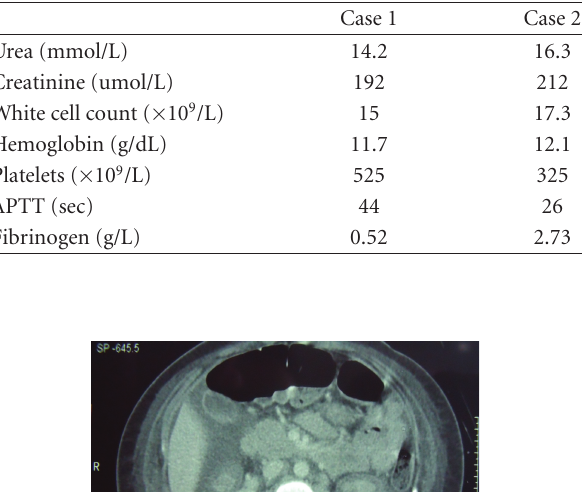
Table 1: Admission laboratory investigations.